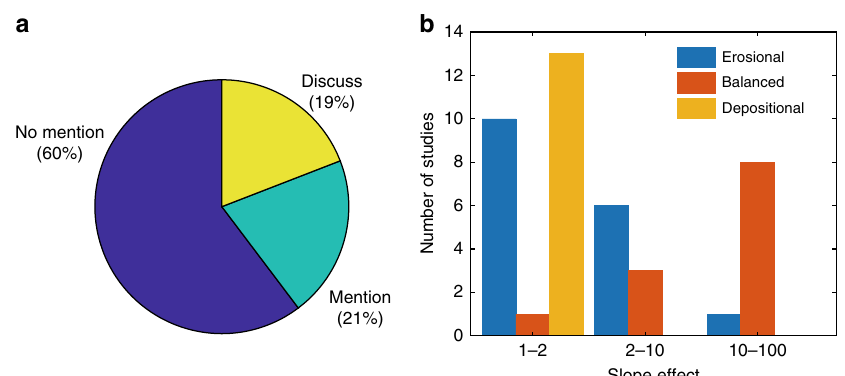
Fig. 1 Literature inventory of slope effects in morphodynamic models. a Model studies that mentioned, discussed, or overlooked the severe channel incision and the arti fi cial increase in slope effect that was necessary to counteract this (see Supplementary Information for inventory). b Studies that mention the magnitude of the slope effect subdivided by modeled environment and the applied slope effect value (1 = default)